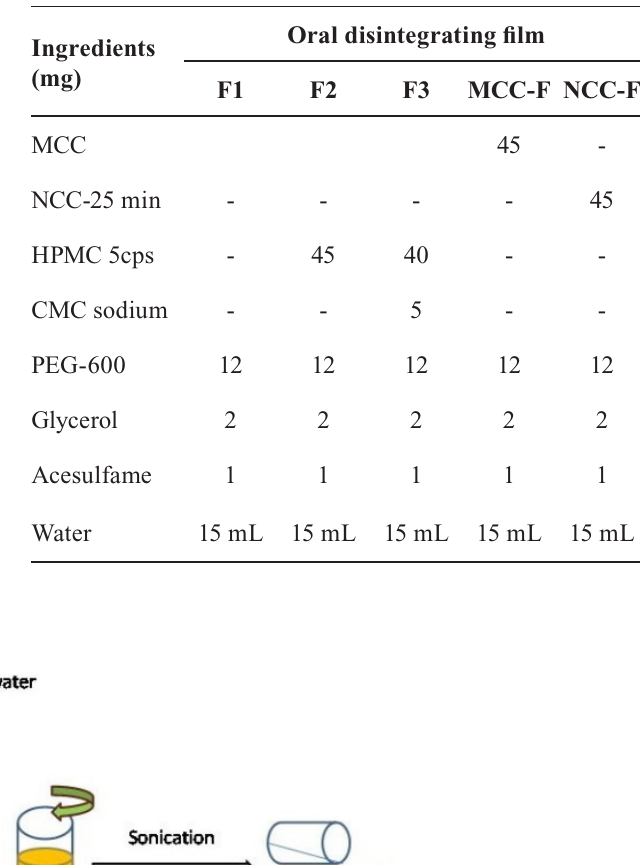
TABLE I - F ormulation composition for oral disintegrating